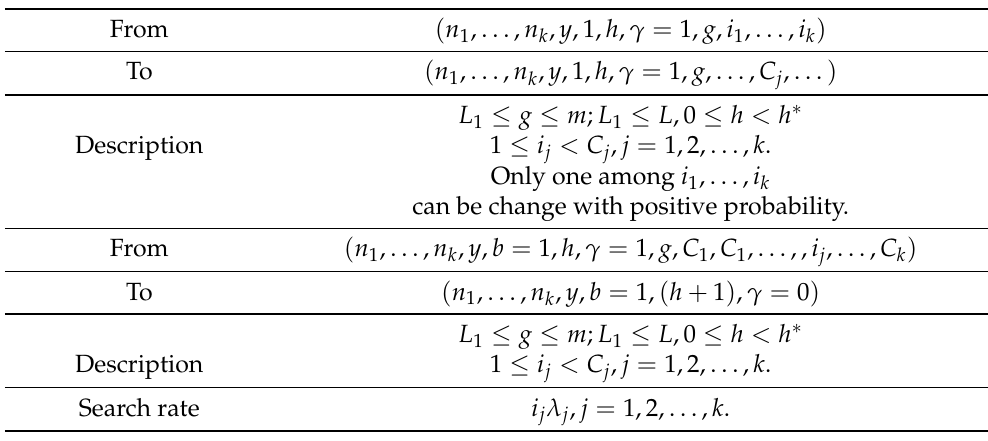
Table 2. Search rates.